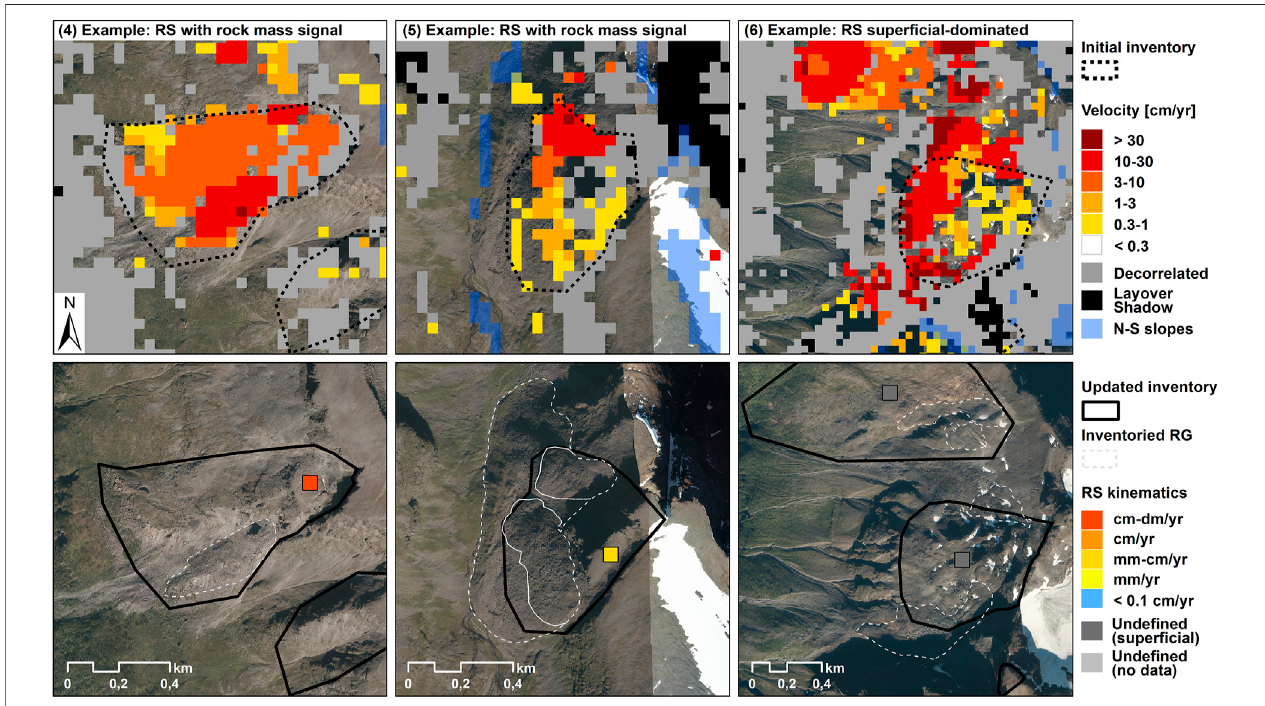
FIGURE 10 | Update of the rockslide (RS) inventory. (4 – 5) Examples of composite landforms where the InSAR signal can reliably be attributed to the movement to the rock mass at speci fi c locations (e.g. top rock plateaus). (6) Example of composite landform where the InSAR results are dominated by super fi cial processes masking the potential signal from the rock mass. Locations of these detailed maps are shown in Figure 11 . Norge i bilder orthophotos from NMA (2020b).